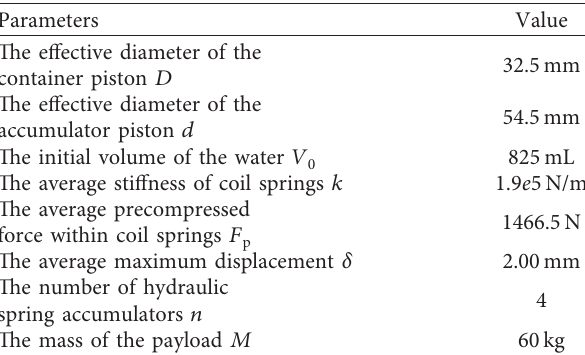
Figure 2: Experimental apparatus. (a) Section view of the MMSI. (b) Dynamic experiment setup. Table 1: Parameters of the experimental